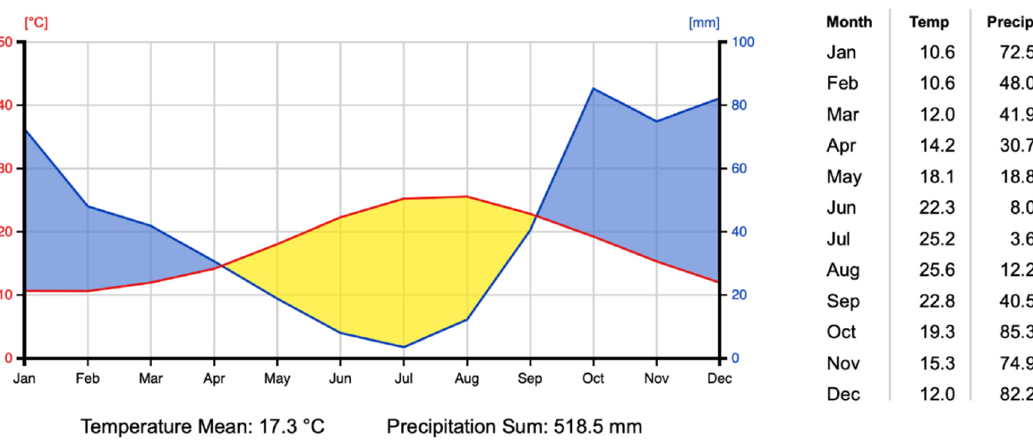
Figure 5. Climate chart for Gela, Sicily, Caltanissetta district, 37°51 ′ 71” N–14°15 ′ 10 ′ ’ E, elevation: 77 m; Climate Class: Cfa; Years: 1963-2019. Source: see [70].